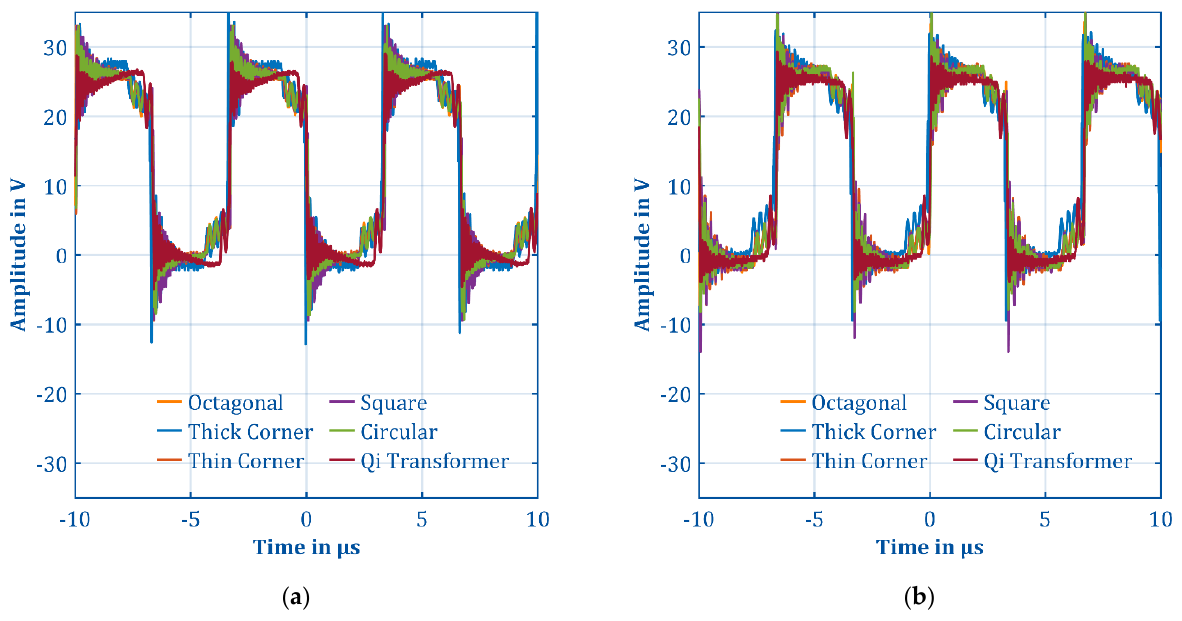
Figure A4. ( a , b ) Show the voltage signals at the secondary winding of the transformers at 150 kHz. Figure A5a,b show the voltage signals at the output of the control electronics driving the primary winding of the transformer before the coupling capacitor at higher frequencies of 1.75 MHz for the Square PCB transformer; all other transformers show no significant difference.